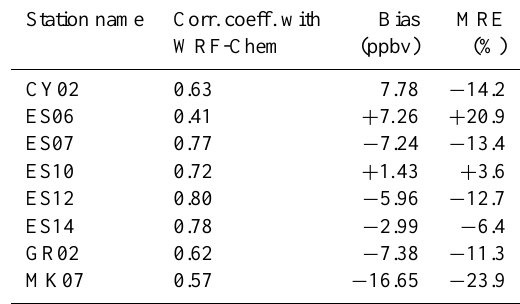
Table 2. Pearson correlation coefficient, bias and the corresponding mean relative error (MRE) of each EMEP and WRF-Chem ground station data localized in Fig. 2, for the period JJA